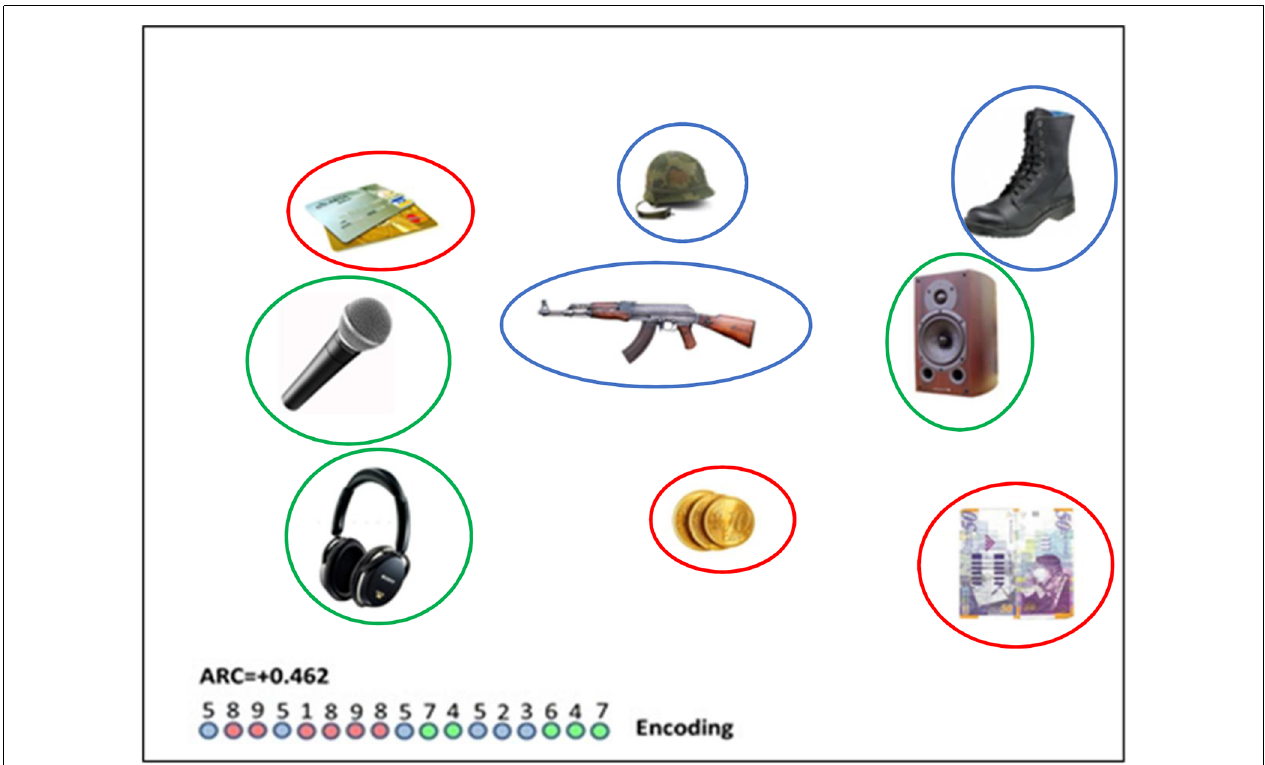
FIGURE 1 | A semantically related slide (i.e., red circles indicate “payment methods”; blue circles indicate “military equipment” and green circles show “audio devices”); colored circles appear in this photo for illustration purposes and did not appear in the experiment. Number sequence relates to the trajectory of eye gaze moving between numbered objects. The encoded clusters involves the repeated colors (8–9);(1–8–9–8);(7–4);(5–2–3);(6–4–7). For this particular sequence, the encoding clustering index (ARC; see “The Eye-Tracking” section below) is 0.462. The (longer) diameter of the objects, as they appeared on the screen was in the range of 100–160 pixels, and the distance between the center of objects was in the range of 350–450 pixels.